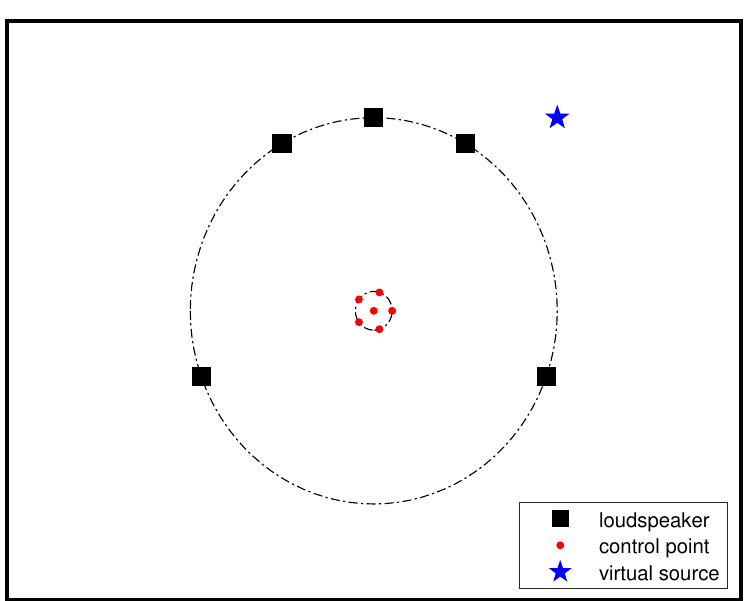
Figure 7. Simulation setup: The 5 loudspeakers are configured as the ITU-T standard 5.1, which are denoted by the black squares. The red dots denote the control points. The blue star indicates the location of the virtual sound